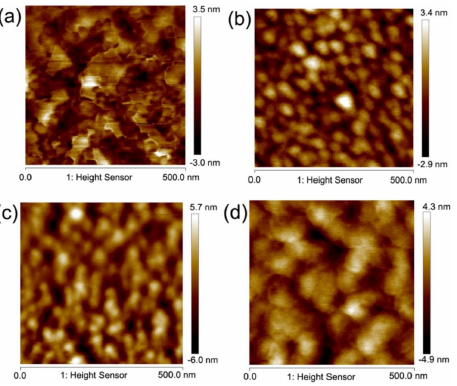
Figure 2. AFM images of Al 0.3 CoCrFeNi with different deposition times of ( a ) 15 min ( b ) 45 min ( c ) 90 min and ( d ) 180 min Reprinted with permission from Ref. [33] Copyright 2017